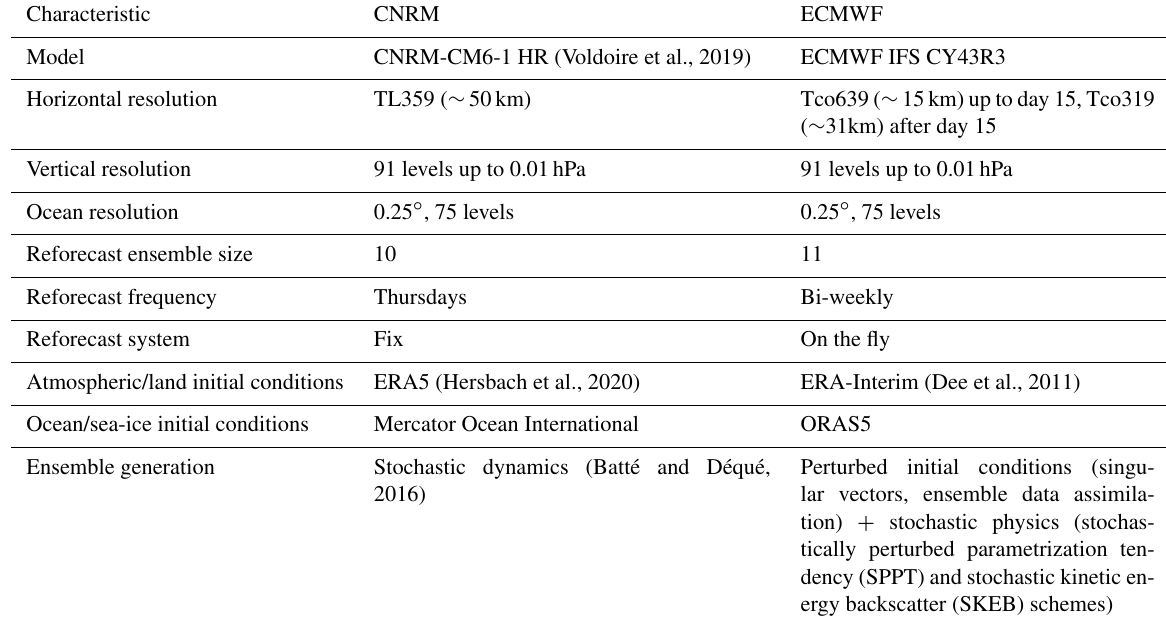
Table 1. Characteristics of the CNRM and ECMWF subseasonal reforecasts.